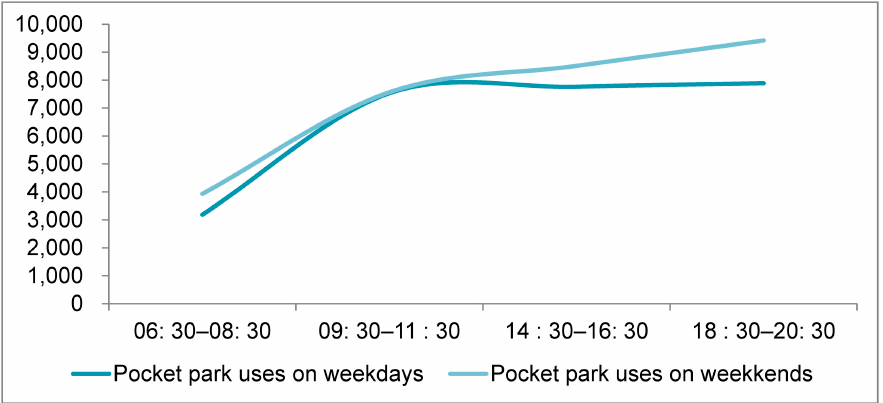
Figure 5. Pocket park uses observed across the four investigation periods on weekdays and weekends.